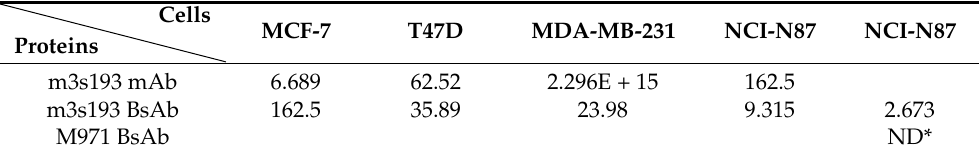
Table 2. Cytotoxicity EC 50 (ng/mL) mediated by the